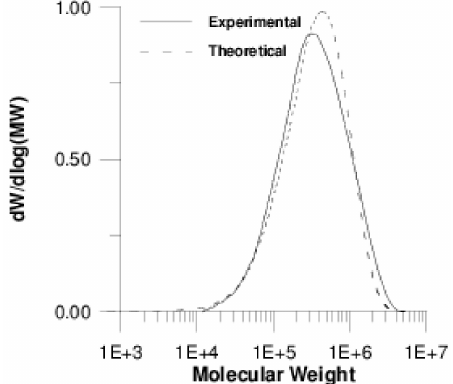
Figure 8. Comparison of the experimental MWD with the predicted one (Model II, 0.1 % ( w / w ) F-GO) for P(S- co -BMA)